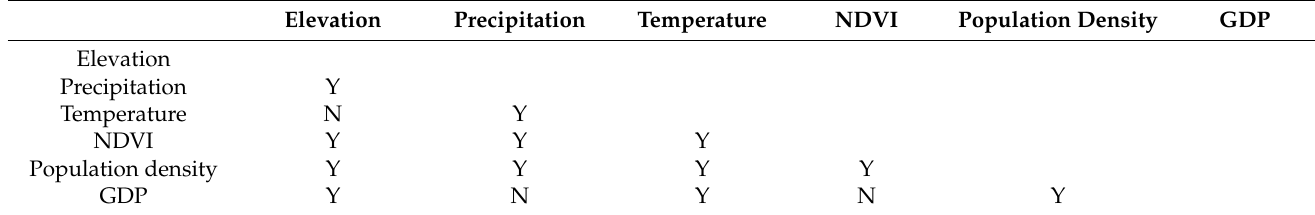
Table 8. Significant differences between driving factors of land cover